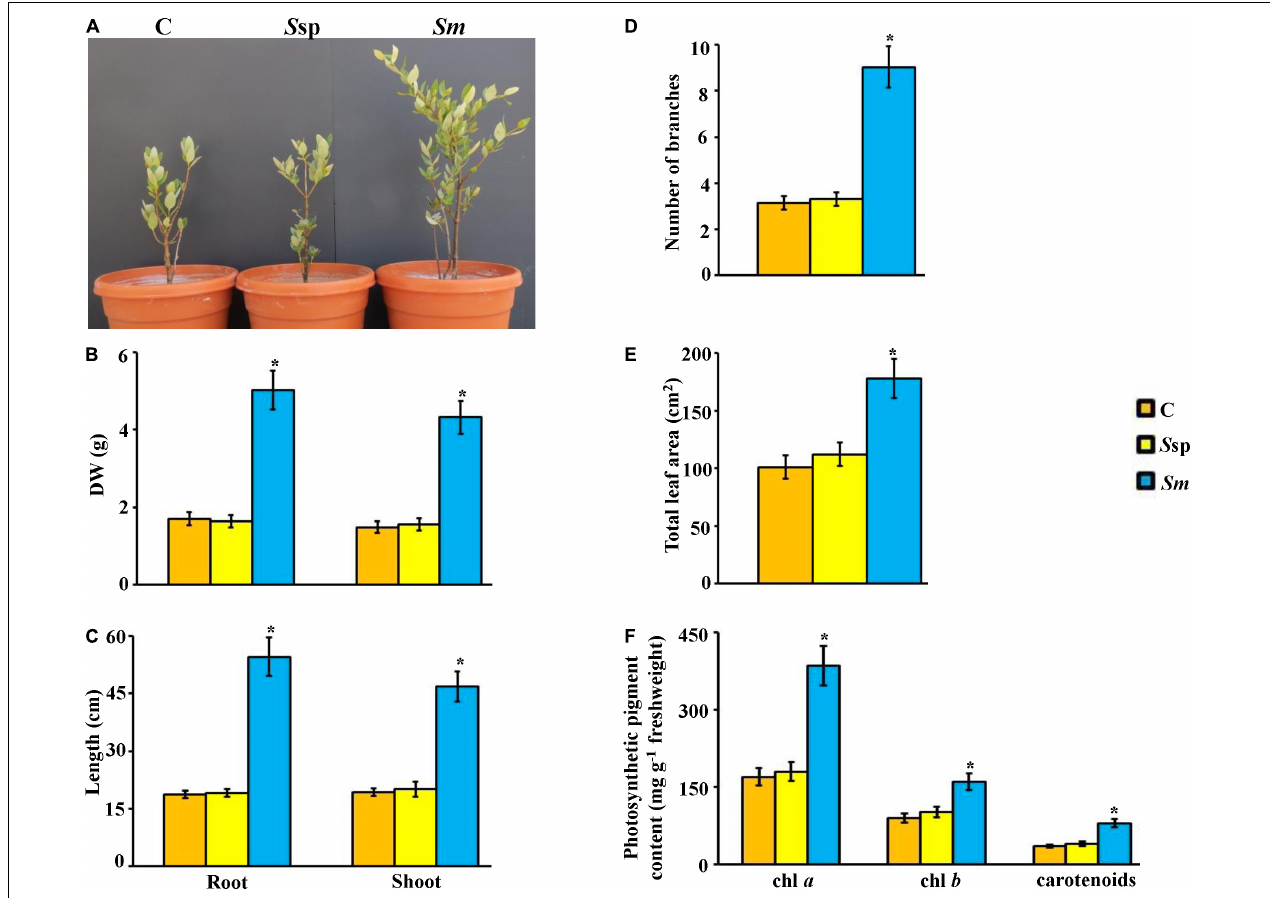
FIGURE 6 | Effect of Streptomyces mutabilis UAE1, on mangrove growth and development. Effect of application of PA-producing S. mutabilis on (A) performance; (B) DW and (C) length of root and shoot tissues; (D) number of branches, (E) total leaf area, and (F) photosynthetic pigment contents of chl a , chl b , and carotenoids on mangrove seedlings. In (A–F) , the figure, DW and length of shoot and root tissues, and photosynthetic pigments were measured at 9 months post planting the inoculated mangrove propagules. Values are means ± SE of 16 replicates for each treatment from two different independent experiments. Mean values followed by an asterisk are significantly ( P < 0.05) different from each other according to Fisher’s protected LSD test. Bars represent SE. DW, dry weight; control (non-inoculated inorganic salt starch broth); S sp, PA-non-producing isolate #5 ( Streptomyces sp. 19-388); Sm , PA-producing isolate #24 ( S. mutabilis UAE1). PA, polyamine; chl,